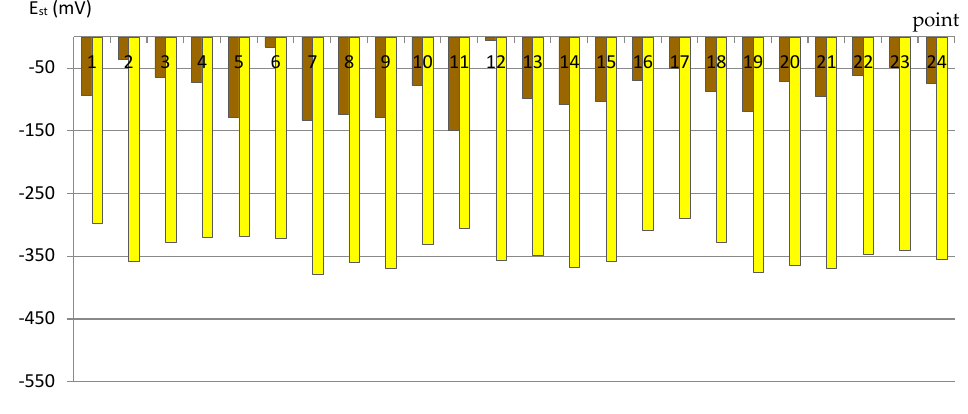
Figure 8. Half-cell potential of reinforcement measured in C_I_n specimens.